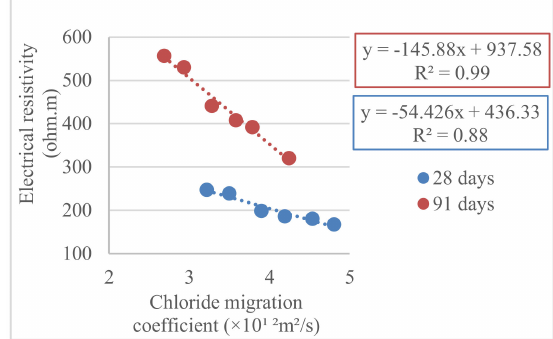
Figure 16. Relationship between chloride migration and electrical resistivity results at 28 and 91